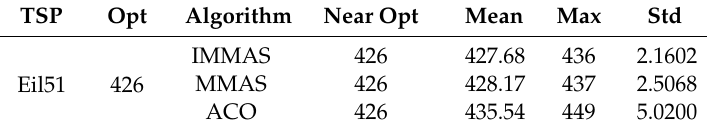
Table 3. Comparison of IMMAS with other ant colony algorithms.